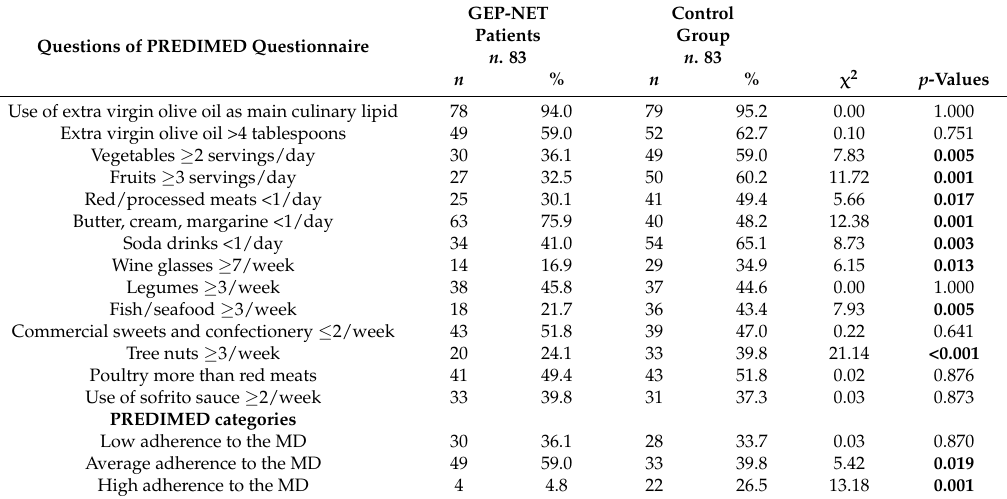
Table 2. Response frequency of dietary components included in the PREDIMED questionnaire of the GEP-NET patients and control